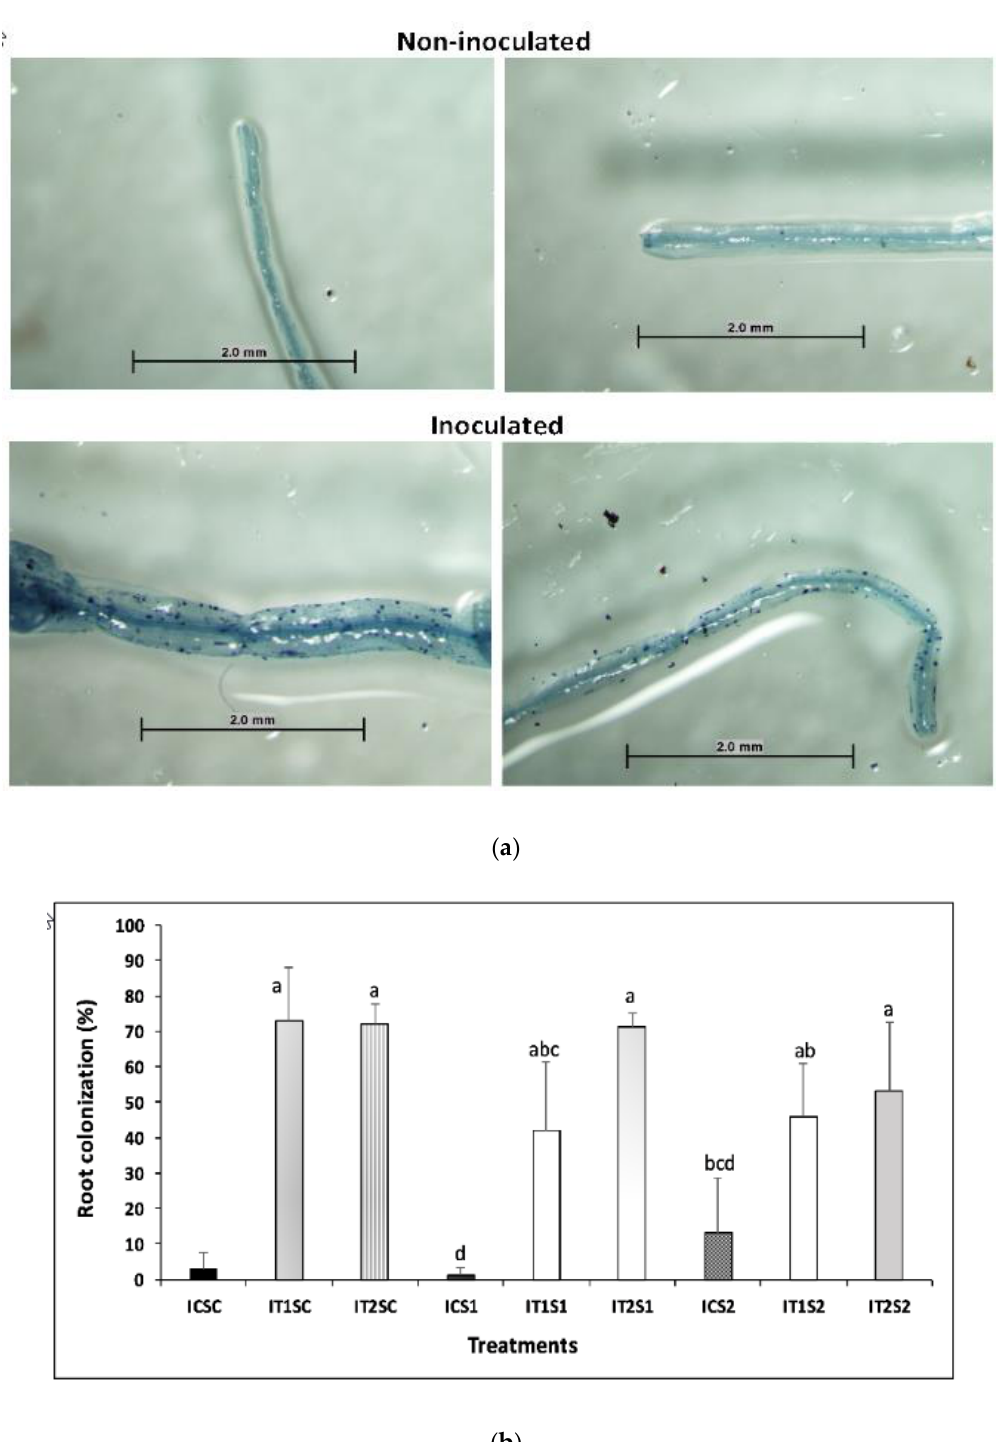
Figure 6. Microscopic observations of snap bean roots stained with 0.05% trypan blue in ( a ) non-inoculated root and root inoculated by arbuscular mycorrhizal fungi (AMF). ( b ) The bar diagram represents the effect of salinity levels (SC = Salinity control 0.6 dS m − 1 EC, S1 = 1.0 dS m − 1 EC, and S2 = 2.0 dS m − 1 EC) and inoculation treatments (IC = No inoculation, IT1 = Mycorrhizal, IT2 = Rhizobium + Mycorrhizal) on AMF root colonization (%) during snap bean productions. Error bars represents standard deviations of mean values. Same letters indicate no statistical difference ( p > 0.05) among the treatments while different letters indicate treatments have significantly difference. Each treatment consisted of n = 10.